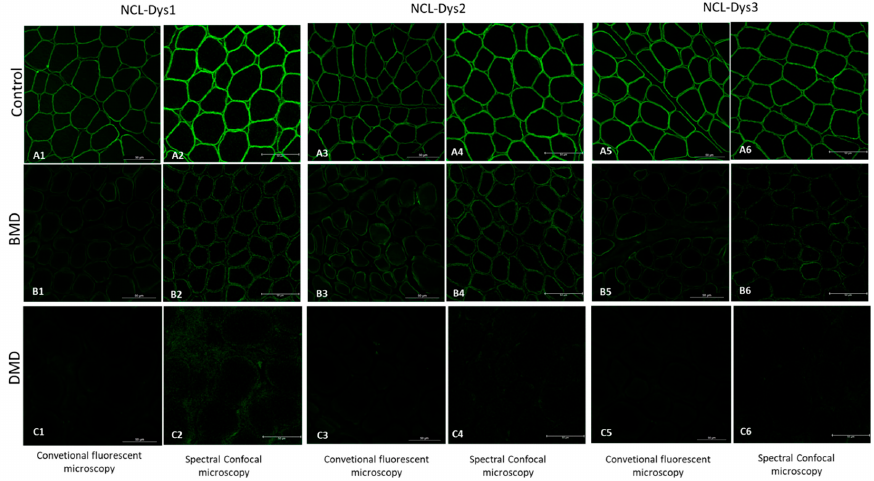
Figure 1. Fluorescent images of the three dystrophin antibodies used (NCL-Dys1, NCL-Dys2 and NCL-Dys3) in control, BMD and DMD muscle biopsies captured with conventional microscopy and spectral confocal microscopy. All the spectral confocal microscopy images ( A2 , A4 , A6 , B2 , B4 , B6 , C2 , C4 , C6 ) show more intense fluorescence signal than the conventional mi- croscopy images ( A1 , A3 , A5 , B1 , B3 , B5 , C1 , C3 , C5 ). This is especially relevant in those DMD cases